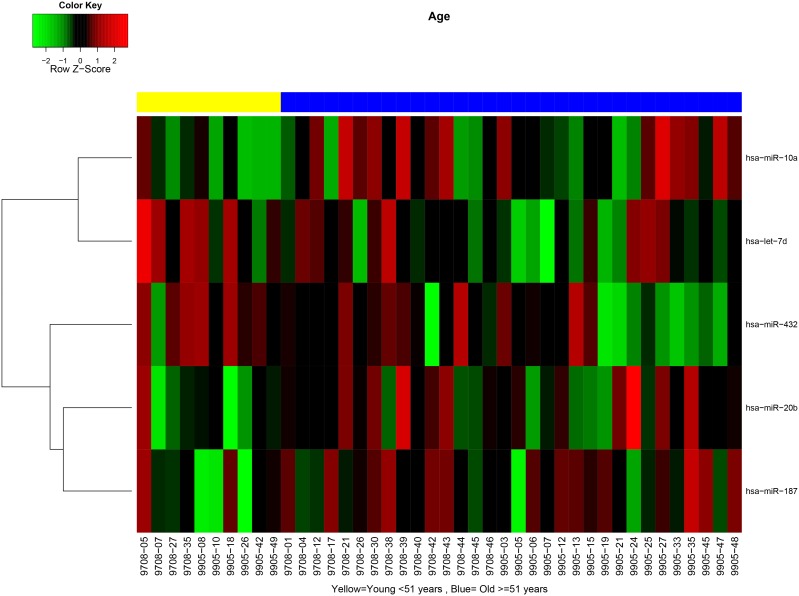
MiRNA signatures differ in tumors from women over and under 51 years of age.Yellow represents patients younger than 51 years of age, and blue represents patients equal to or older than 51 years of age.